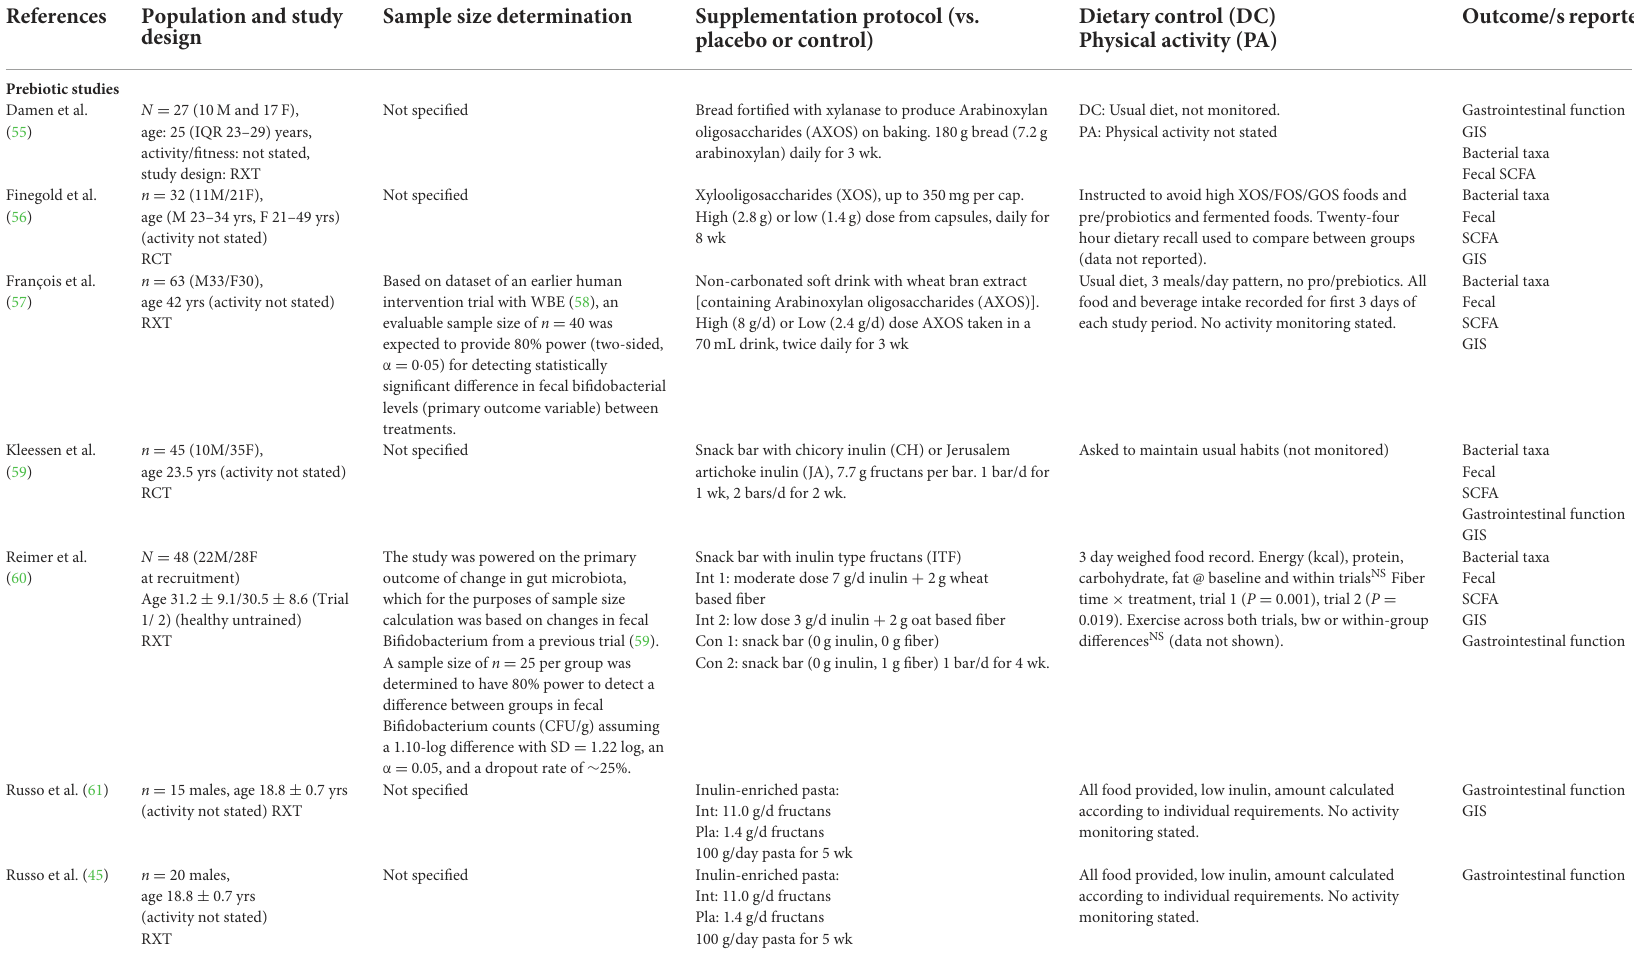
TABLE 3 Systematic review search results and study characteristics of included studies that attempted to determine the impact of prebiotic, probiotic and synbiotic supplementation on gastrointestinal outcomes at